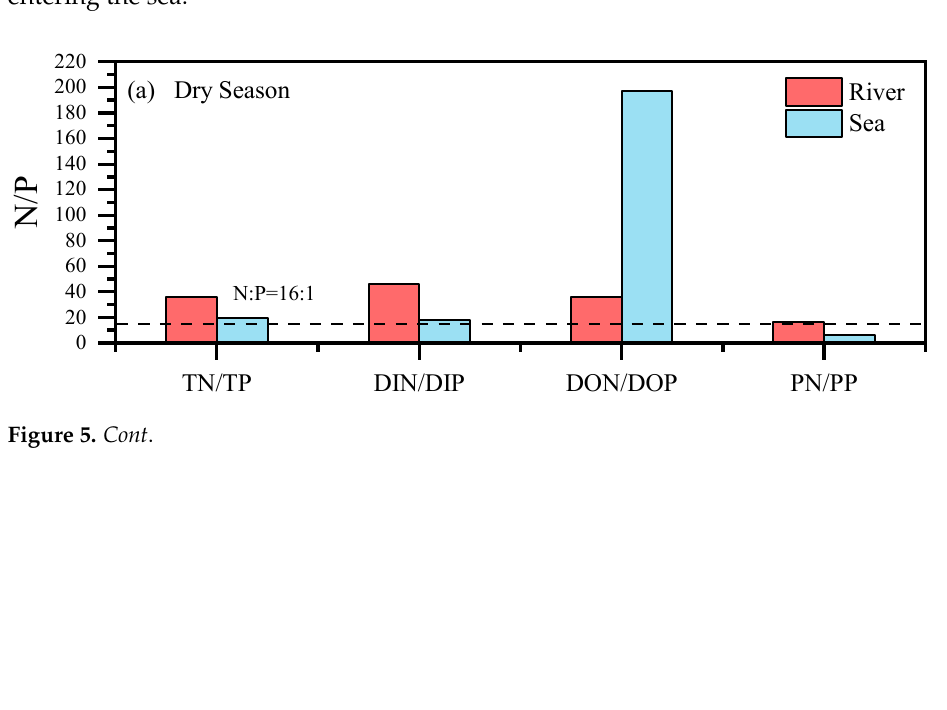
Figure 5. Seasonal variation in N/P in estuaries and seawater of the Maowei Sea. 3.5. Correlation Analysis of Influencing Factors on Water Quality in Maowei Sea The correlation coefficients of the influencing factors showed that the TN and TP concentrations in the MWS exhibited significant changes in different seasons (Figure 6). There was a highly significant negative correlation between S and TN in the dry season ( p < 0.01) but not in the wet and normal seasons. It indicated that the TN in the surface water of MWS was not only influenced by terrestrial input but may also be input from other sources [11]. S and TP were not significantly correlated in all three seasons. This suggested that TN and TP concentrations in MWS may be related to groundwater input, urban sew- age, aquaculture wastewater input and freshwater discharge from the estuaries. In many cases, the flux of basement input nutrients was also greater than that from local rivers, such as in Sanggou Bay, China [51], eastern Laizhou Bay, China [52], and Maalaea and Kuau, USA [53]. DIN and DIP concentrations during the normal season were highly sig- nificantly positively correlated (Figure 6) and insignificantly correlated during the dry and wet seasons. This indicated that the main factors affecting the transport and transfor- mation processes of nitrogen and phosphorus are not the same. During the wet and dry seasons, changes in precipitation and river flow, river leached on agricultural land,